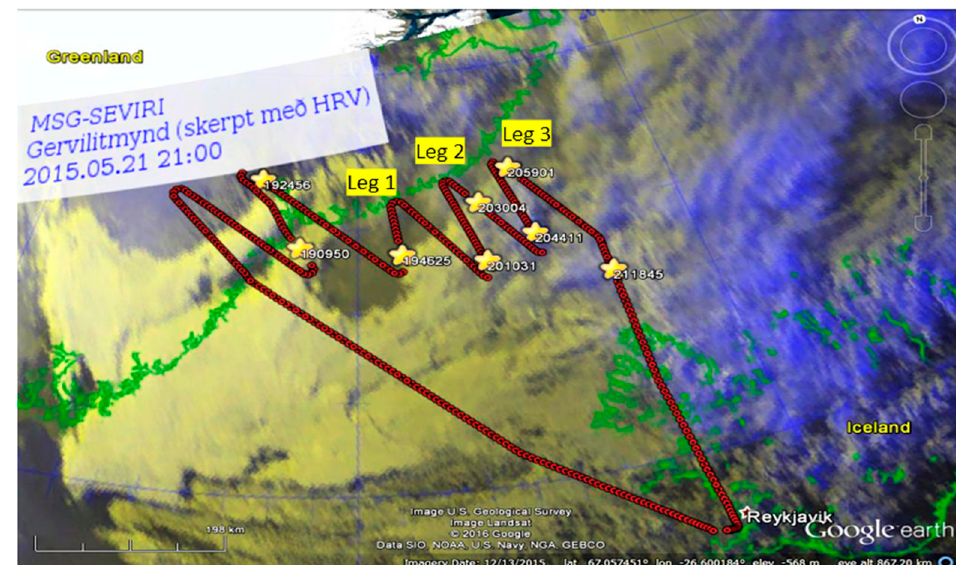
Figure 6. DC-8 Flight track, DAWN profile locations (red dot) and dropsonde locations (gold star) during the 21 May 2015 flight mission. Satellite imagery from MSG-SEVIRI (Data processed by the Icelandic Meteorological Office) at 21Z. Labels for NW–SE legs provided at the beginning of the leg (after the turn).